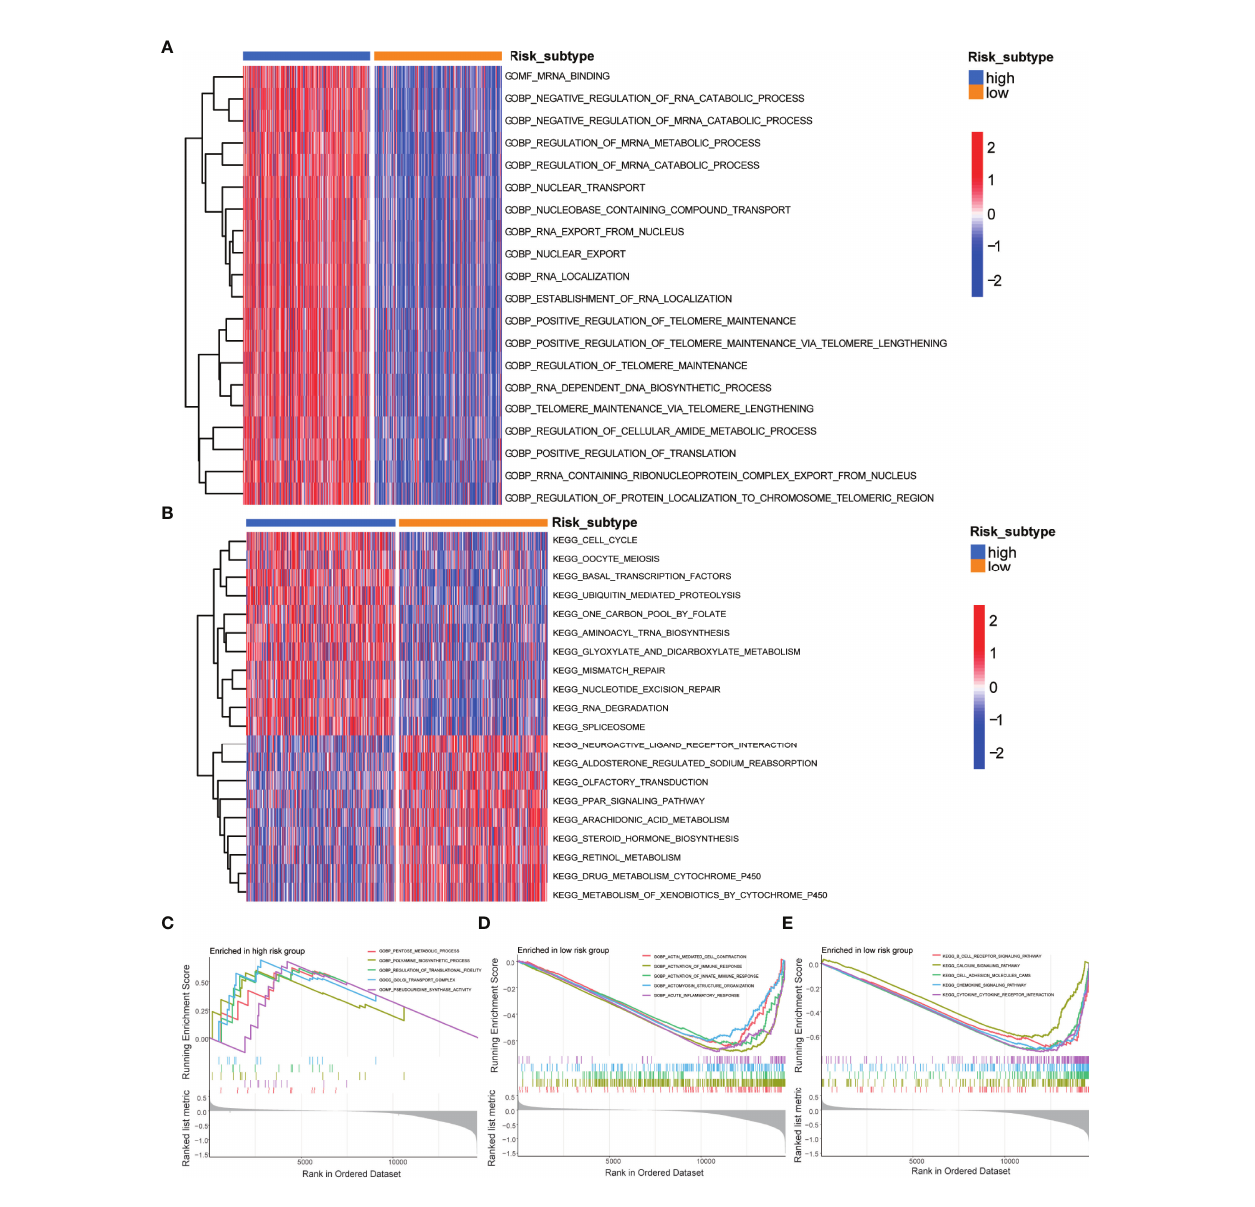
FIGURE 3 | GSVA and GSEA of the m5C prognostic model. (A) GSVA of GO terms between high-risk and low-risk subtypes, in which red and blue represent activated and inhibited biological processes, respectively. (B) GSVA of KEGG terms between high-risk and low-risk subtypes, in which red and blue represent activated and inhibited pathways, respectively. (C) GSEA of the signi fi cantly enriched GO terms in the high-risk subtype. (D) GSEA of the signi fi cantly enriched GO terms in the low-risk subtype. (E) GSEA of the signi fi cantly enriched KEGG terms in the low-risk